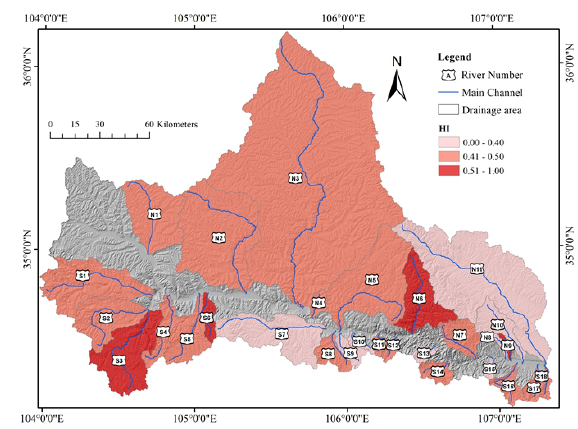
Figure 7. HI distribution map in this